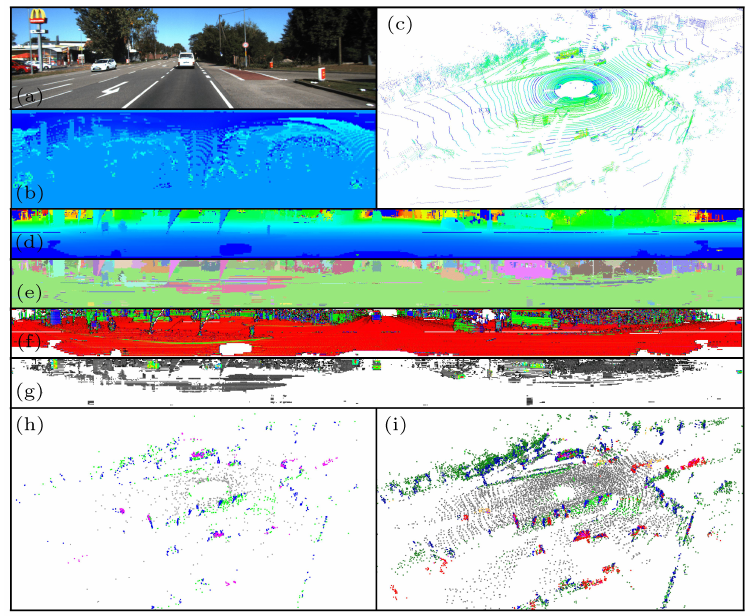
Figure 1. Overview of the proposed InTEn-LOAM system. ( a ) The color image from the on-board camera. ( b ) The projected scan-context segment image. ( c ) The raw point cloud from the on-board Velodyne HDL-64 LiDAR colored according to intensity. ( d ) The projected cylindrical range image colored according to depth. ( e ) The segmented label image. ( f ) The estimated normal image (x, y, z). ( g ) The intensity image of non-ground points. Only reflector features are colored. ( h ) Various types of feature (ground, facade, beam, reflector) extracted from the current lazer scan. ( i ) The current point features align with the local feature map that is in use so far (dynamic object in the current